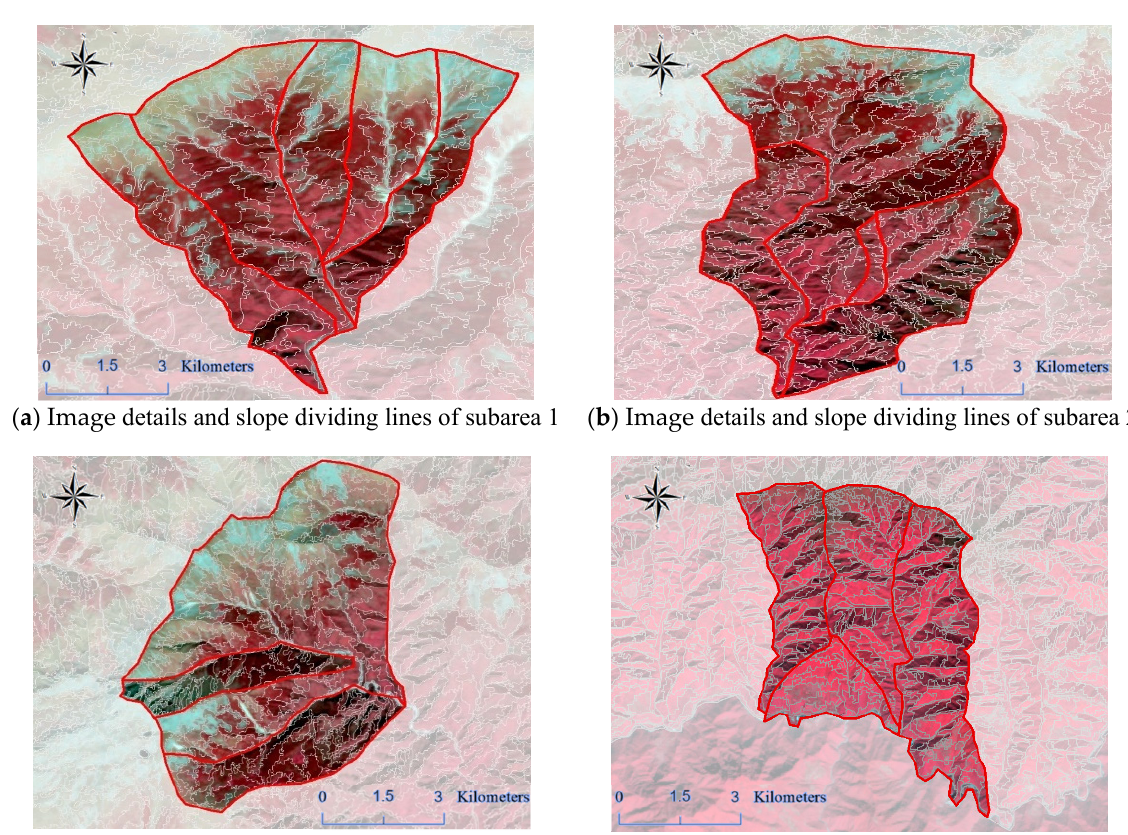
( d ) Image details and slope dividing lines of subarea 4 Figure 6. Details of topographic zones (the polygons with red boundary lines) and the extracted geo-objects (the polygons with white boundary lines) in four subareas marked in Figure 3 (the bottom image is the GF-2 image with a 4/3/2 band combination).